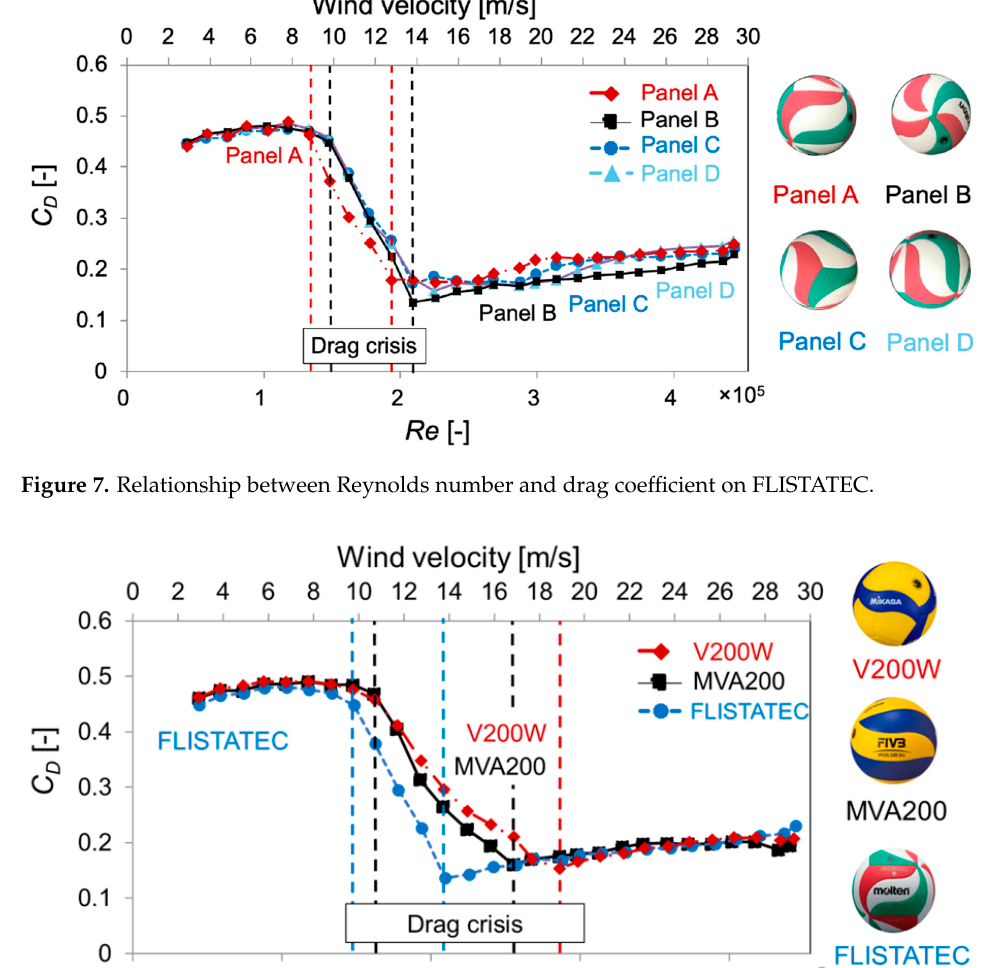
Figure 6. Relationship between Reynolds number and drag coefficient on V200W.